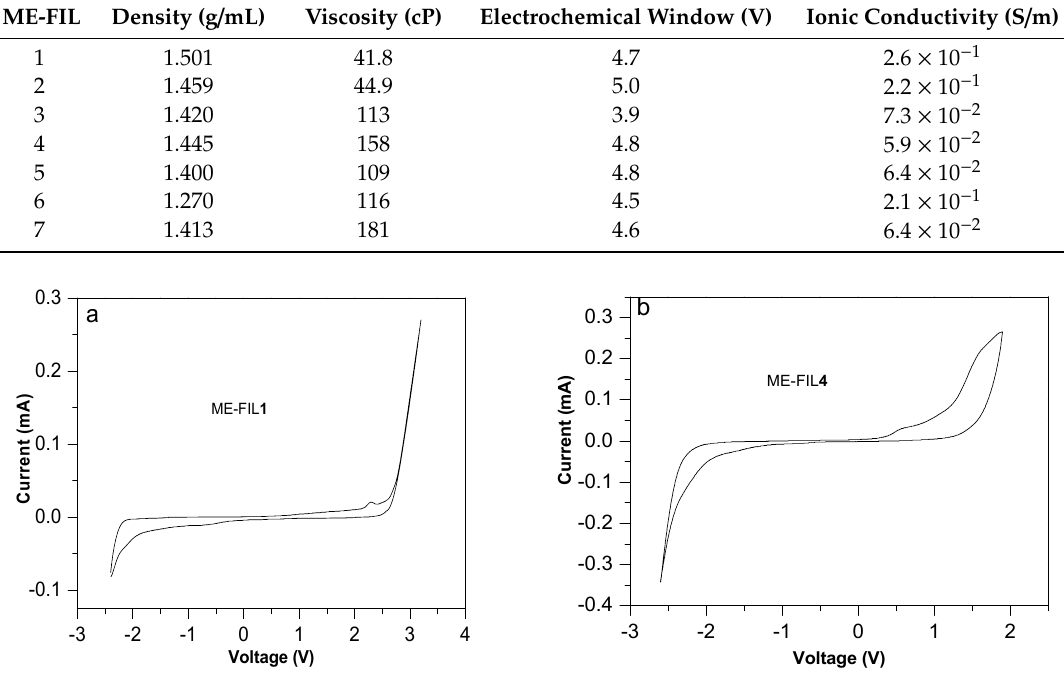
Table 1. Density, viscosity, electrochemical window, and ionic conductivity of ME-FILs at 25 ◦ C.